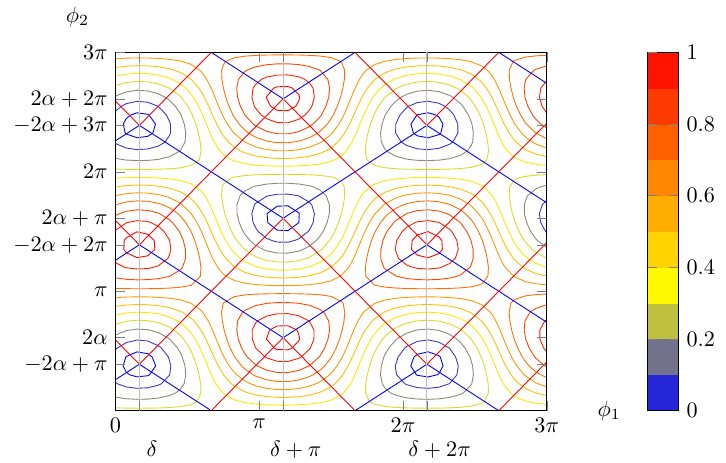
Figure 8. Contour plot for α = 55 ◦ and δ = 30 ◦ . In general, maxima and minima are not placed on a square grid. Blue lines join maxima lying on the same “ridge” or minima in the same “valley”, whereas red lines connect maxima separated by a “valley” or minima with a “ridge” in between,